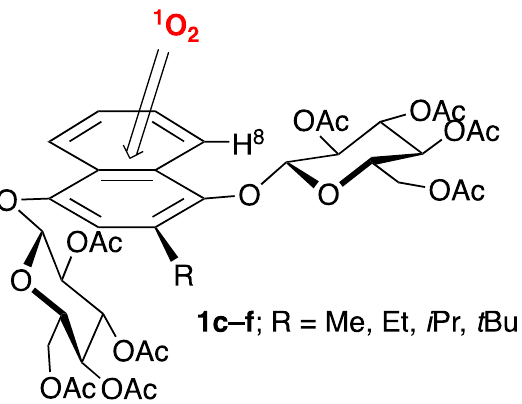
Figure 4. Proposed conformations of naphthalenes 1c – f and preferred attack of 1 O 2 . Finally, because our structural assignment was hitherto only based on NOESY mea- surements and calculations, we wanted to determine the absolute configurations unequiv- ocally. Thus, we selected EPO 1 S ,4 R - 2f , which we could isolate in analytically pure form, which may have the same configuration as all main isomers, and which is stable enough for further transformations. Epoxidation with m -chloroperoxybenzoic acid (MCPBA) in dichloromethane afforded a single diastereomer syn - 7 as shown by the NMR of the crude product. This is in accordance to literature-known epoxidations of simple naphthalene EPOs [51] and can be explained by steric interactions and hydrogen bonding to the per- oxide bridge. The epoxide syn - 7 was isolated by column chromatography in 76% yield in analytically pure form (Scheme 3). Finally, the chiral carbohydrate auxiliaries could be removed by catalytic hydrogenation of the O–O bond, and naphthoquinone epoxide 2 S ,3 R - 8 was isolated in 63% yield, besides some decomposition products. Now, we could determine its absolute configuration unequivocally by comparison of the optical rotation with literature-known epoxide 2 R ,3 S - 8 , which was synthesized from chiral hydroperoxides in 82% ee